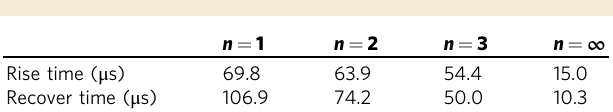
Table 1 Rise and recover time of photo response